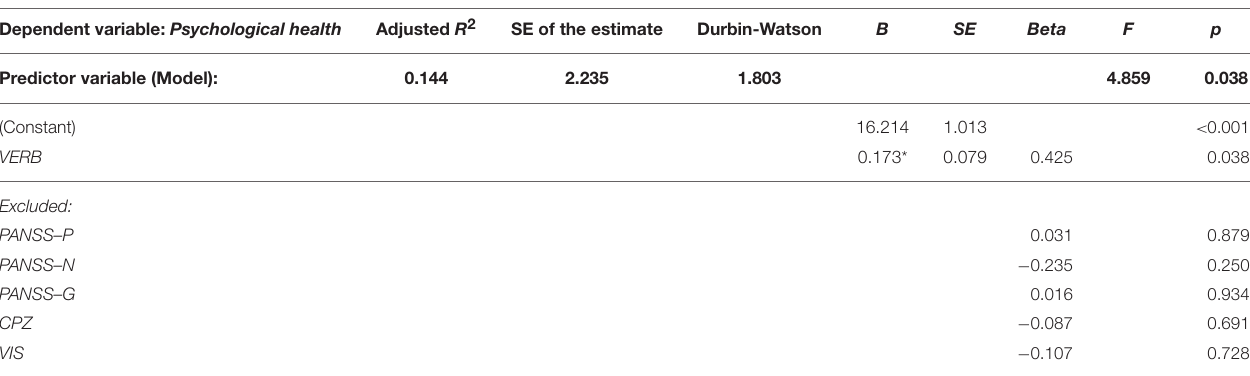
TABLE 7 | Regression model of clinical and neuropsychological variables (predictors) on perceived quality of Psychological health (dependent variable). Dependent variable: Psychological health Adjusted R 2 SE of the estimate